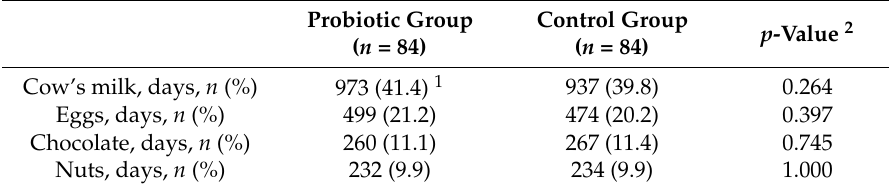
Table 4. Cumulative total-group days mother intake of foods suspicious to produce colic in breastfed